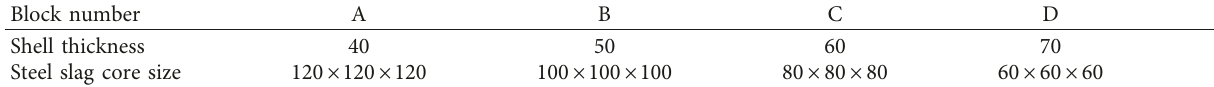
Table 4: Test block structure size (mm).